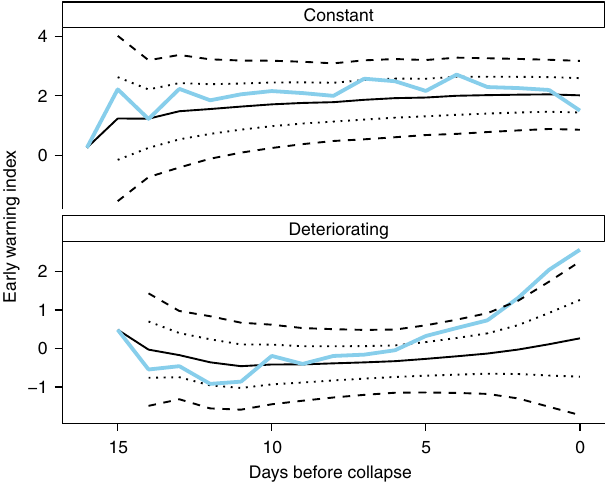
Figure 6 | How the threshold value determines whether an early warning signal is present. As in Drake and Griffen, an early warning signal was considered to be generated when the value of the early warning index (blue lines) exceeded its running mean (solid black lines) by either 1 (dotted black lines) or 2 s (dashed black lines). This is highlighted above with an example calculated for a single a population from each of the constant and deteriorating experimental